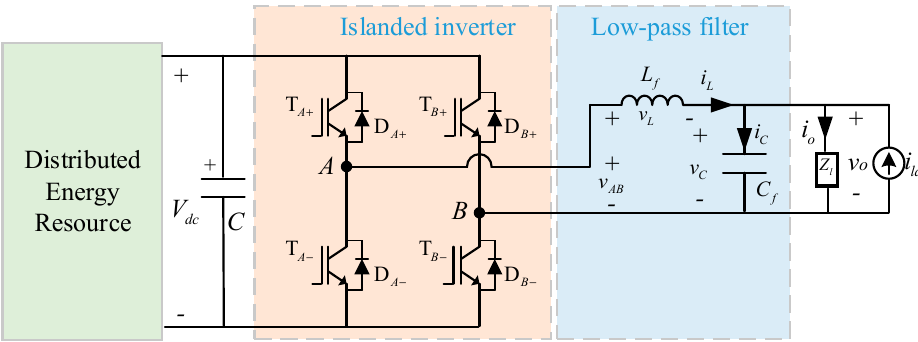
Figure 1. Schematic diagram of islanded inverter.